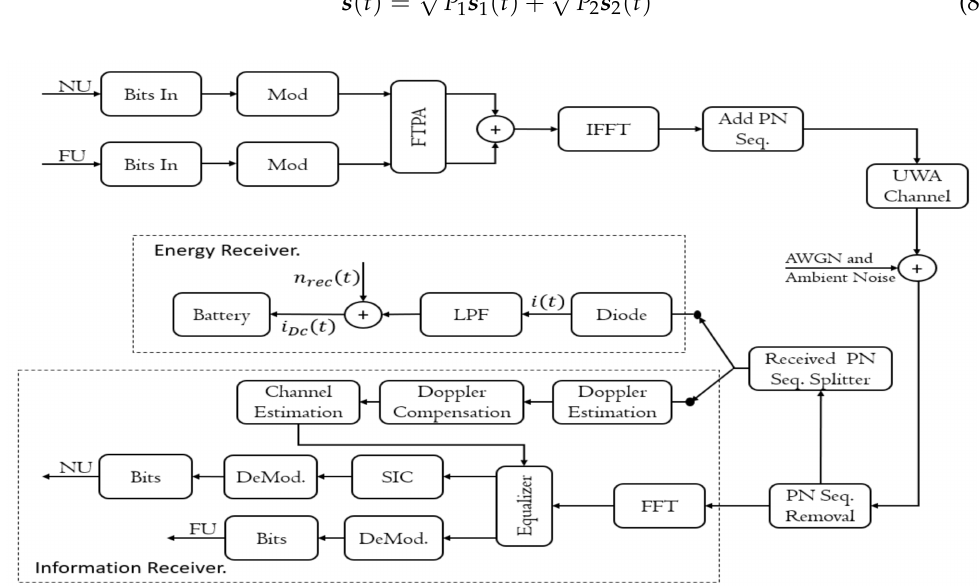
Figure 3. The TDS-OFDM-NOMA communication